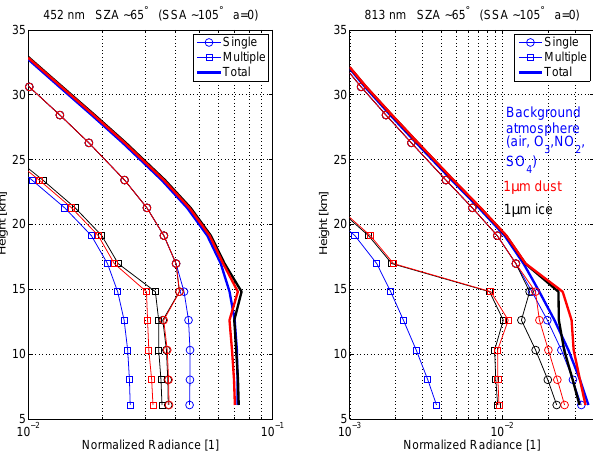
Fig. 6. The effect of a 1km layer of dust (red) or ice (black) at 14– 15km, superimposed on a background atmosphere (blue). Round markers indicate single scattering, square markers indicate multiple scattering, and thick lines indicate total